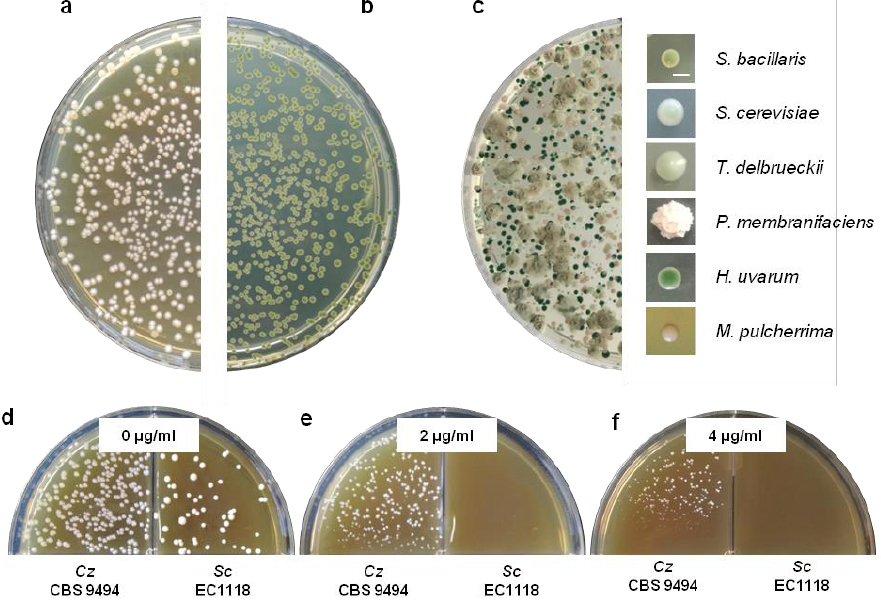
Figure 3. S. bacillaris colony morphology. Colonies of C. zemplinina (syn., S. bacillaris ) strain CBS 9494 as observed in standard YPD ( a ) or differential WL-nutrient agar media ( b ), after incubation during 72 h at 25 °C. S. bacillaris forms small pale green, creamy colonies in WL-nutrient agar ( b ). “Multi-species” reconstitution experiment of common non- Saccharomyces yeasts ( Hanseniaspora uvarum , Pichia membranifaciens , Metschnikowia pulcherrima, and Torulaspora delbrueckii ), S. cerevisiae (strain EC1118), and C. zemplinina (strain CBS 9494) ( c ). The photography shows the particular morphology and color aspects, on WL-nutrient agar, of the various plated yeast species [49]. Bar in ( c ) represents 1 mm. Identical magnification for all colonies is shown. S. bacillaris ( C.